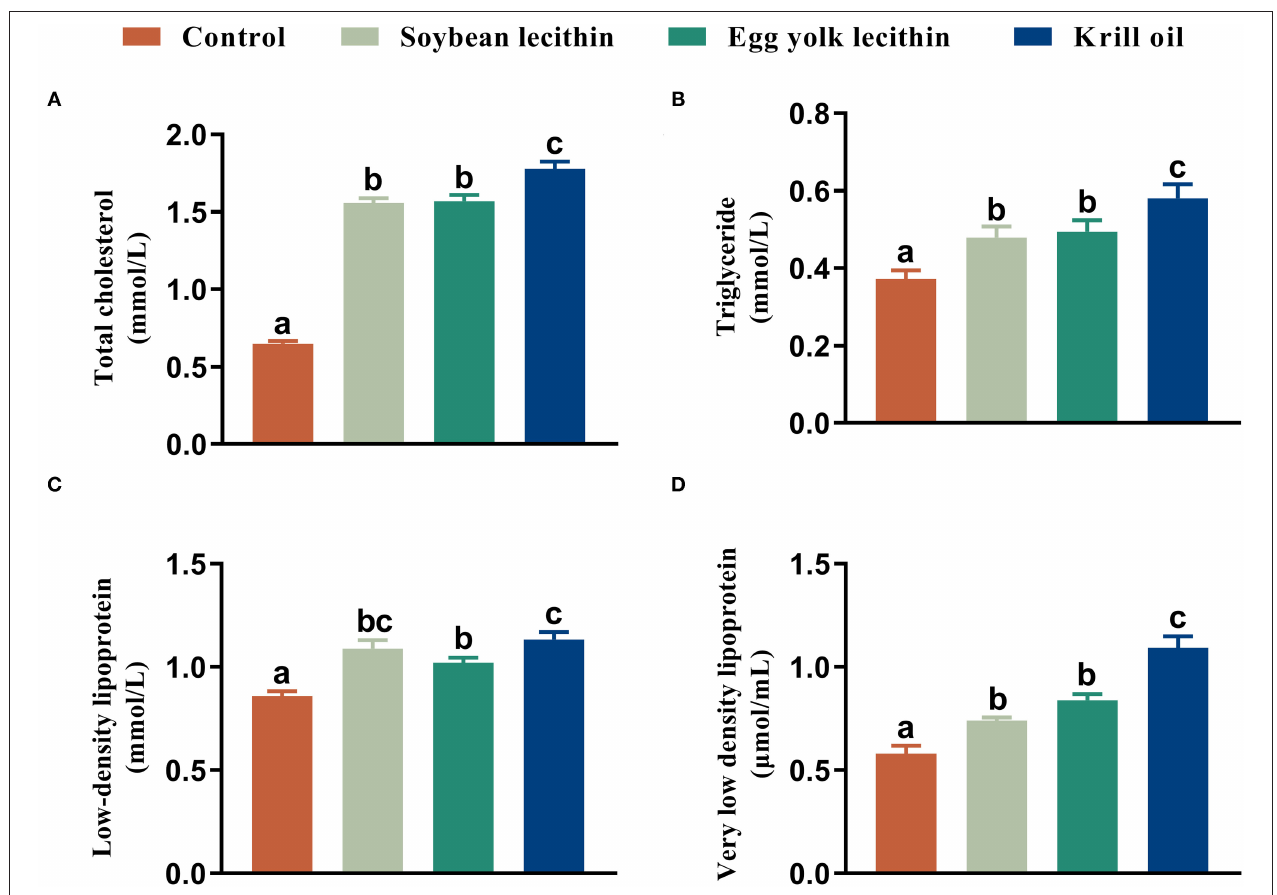
FIGURE 4 | Biochemical composition of female L. vannamei fed with different experimental diets. (A) Content of total cholesterol in serum. (B) Content of triglyceride in hepatopancreas. (C) Content of low-density lipoprotein in serum. (D) Content of very low-density lipoprotein content in serum. The values are the mean ± standard errors ( n = 4). Bars with different superscripts are significantly different ( p < 0.05, single factor analysis of variance and Duncan’s